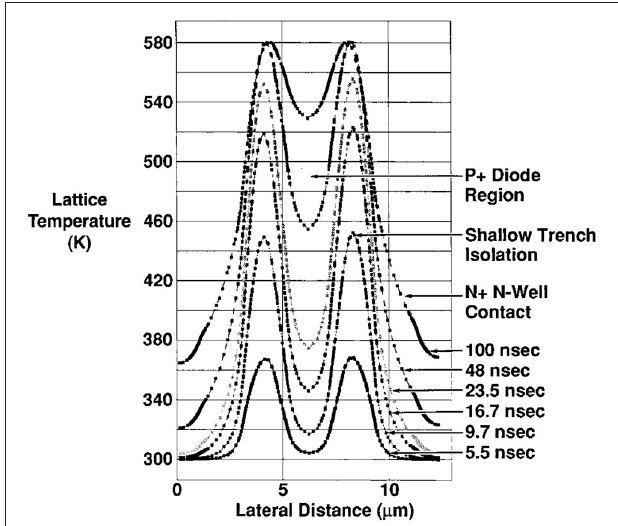
FIGURE 3 | Peak Lattice Temperature for processes with different isolation structures for 0.25 µ m CMOS technology (with permission from the ESD